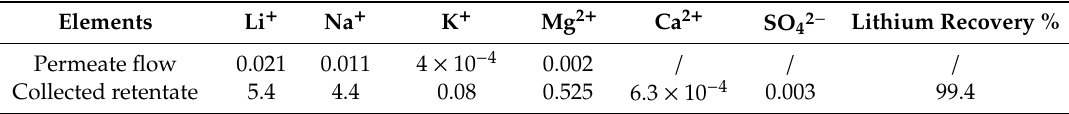
Table 6. The final compositions of the permeate flow and collected retentate.